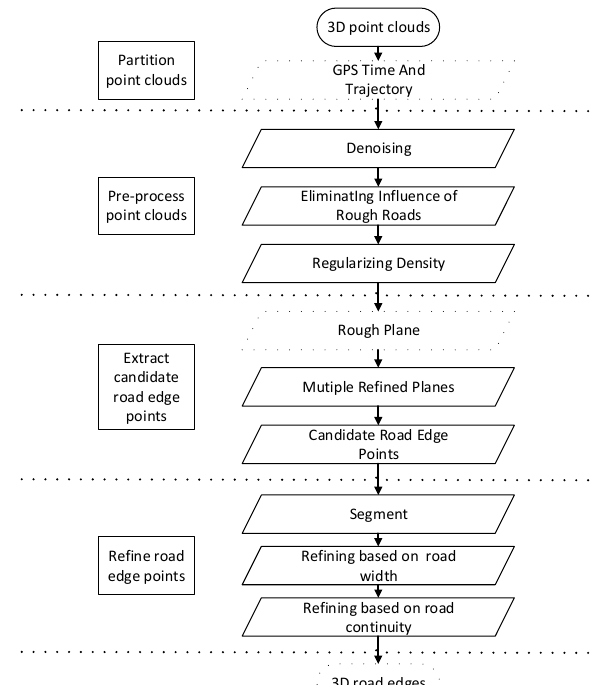
Figure 2. Framework of extracting road edge